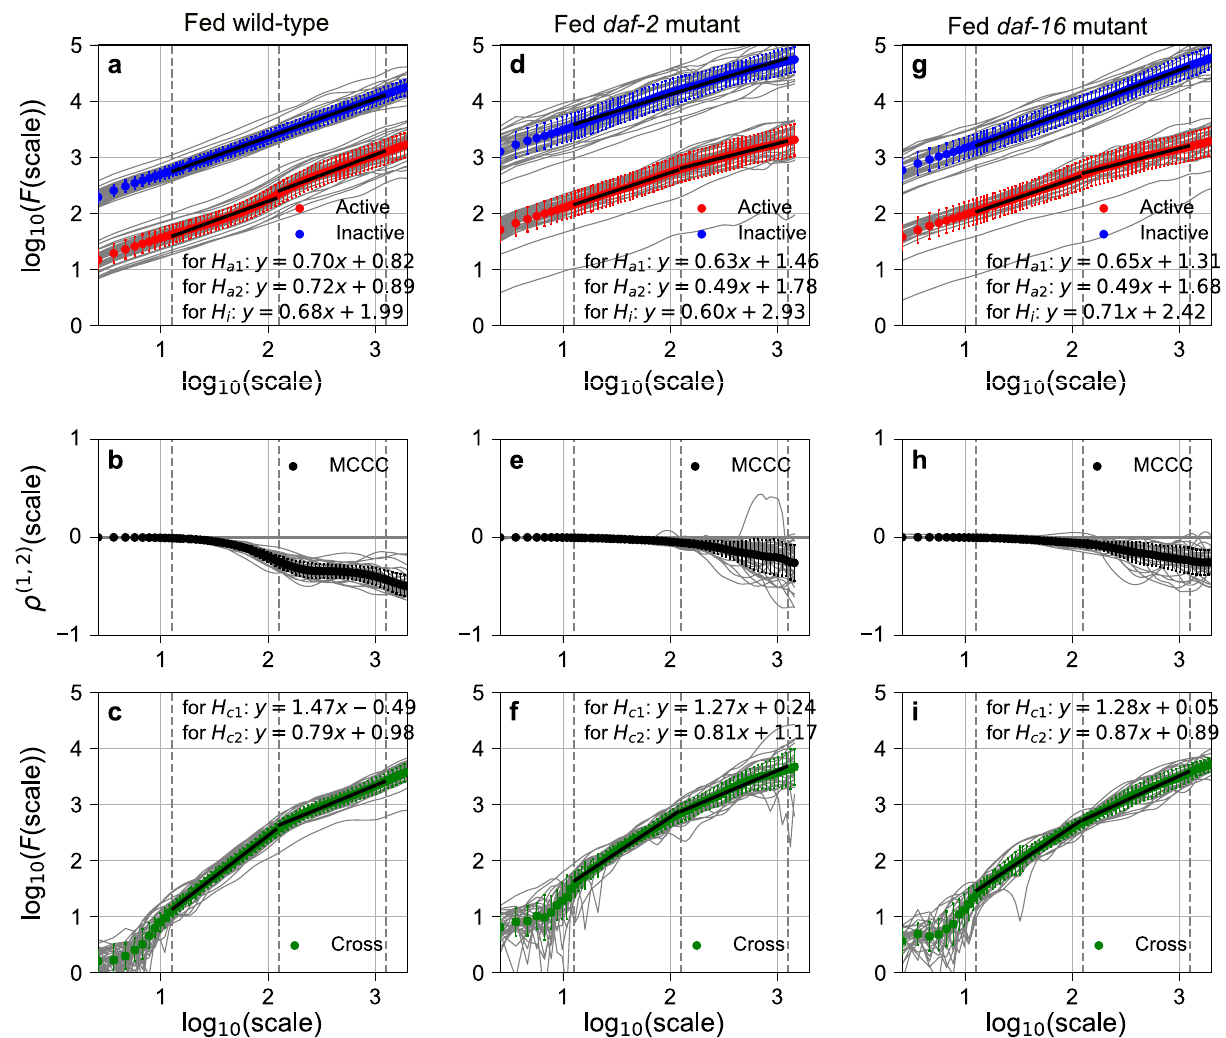
Figure 3. Long-range auto-/cross-correlations and multiscale cross-correlation coefficients in fed C. elegans behavior. Averaged noise function F ( s ) of active (red) and averaged cross-noise function F ( 1,2 ) ( s ) (green) among individual animals (grey) were fit with linear function from 1.1 to 2.1 and from 2.1 to 3.1 across scale ( s ) at shorter and longer round scale for fed wild-type ( a , c ), daf-2 ( d , f ), and daf-16 ( g , i ), respectively. Averaged noise function F ( s ) of inactive (blue) DRSs was fit from 1.1 to 3.1. Averaged multiscale cross-correlation coefficient (MCCC; black) among individual animals (grey) were plotted against scale ( s ) for fed wild-type ( b ), daf-2 ( e ), and daf-16 ( h ). Error bars are standard